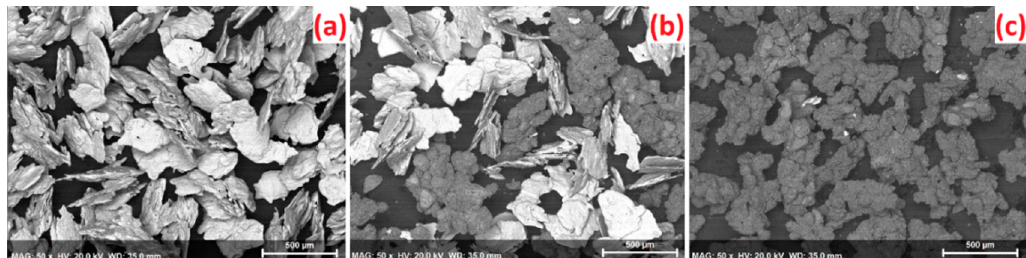
Figure 16. Backscattered electron micrographs of ( a ) concentrate, ( b ) middlings, and ( c ) tailings fractions produced from elutriating separation of the 250–500 µm size fraction of the reduced product. White or light grey particles are alloy whereas dark particles represent gangue.